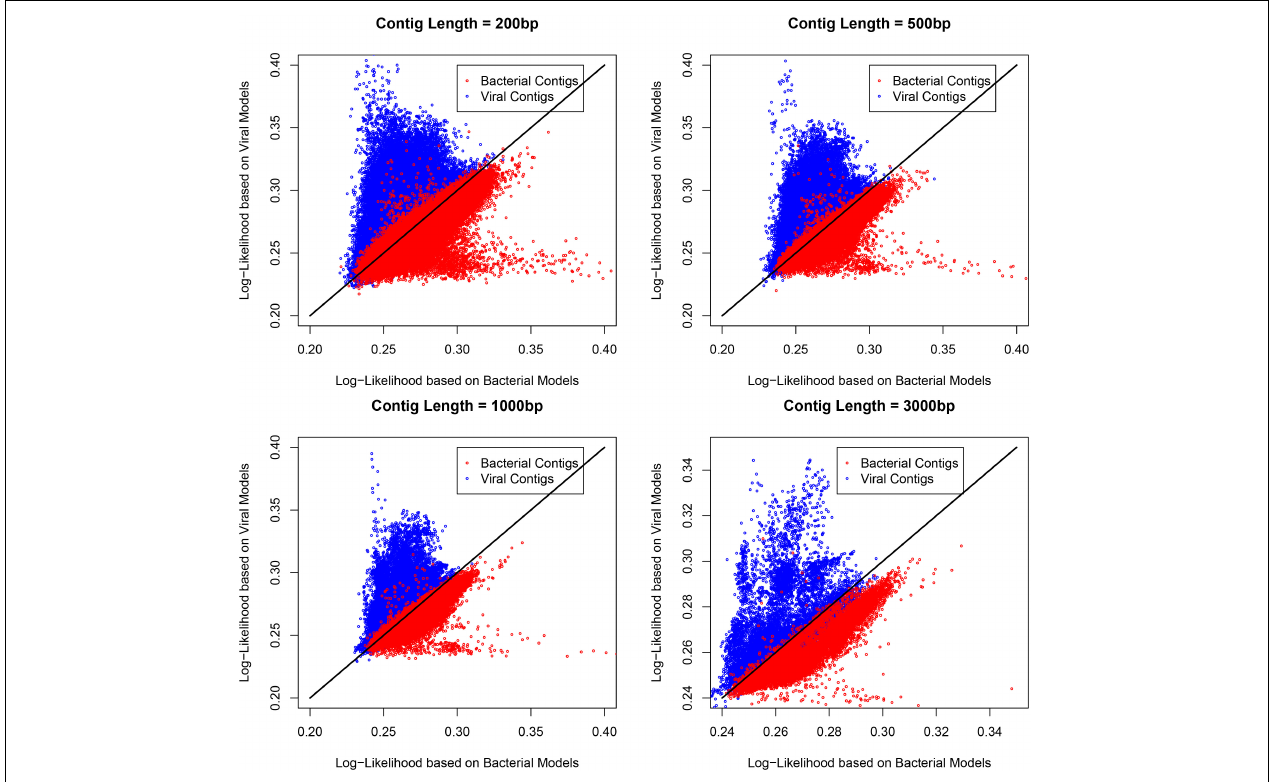
FIGURE 2 | The scatterplots of the log-likelihoods for contigs with different length. The number of cluster bins was 4 and Markov order was 9 for constructing the training model. The length of contigs were 200, 500, 1,000, and 3,000 bp.